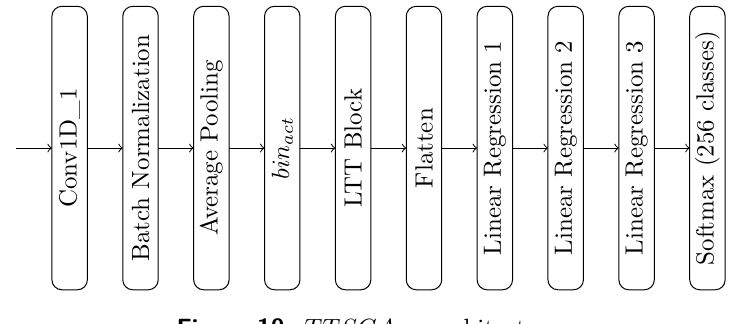
Figure 10: TTSCA big